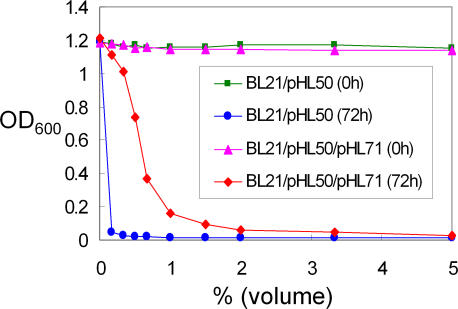
Production of 6d-EryDBlue circles, αMEB conversion to erythromycin D by BL21/pHL50. Red diamonds, 6dEB conversion to 6d-EryD by BL21/pHL50/pHL71.Cells were induced at 20 °C with 10 μM IPTG, and samples were collected 72 h after induction. αMEB or 6dEB was added at a final concentration of 100 mg/l. The abscissa (%) indicates the volume of E. coli culture medium added to LB inoculated with B. subtilis.